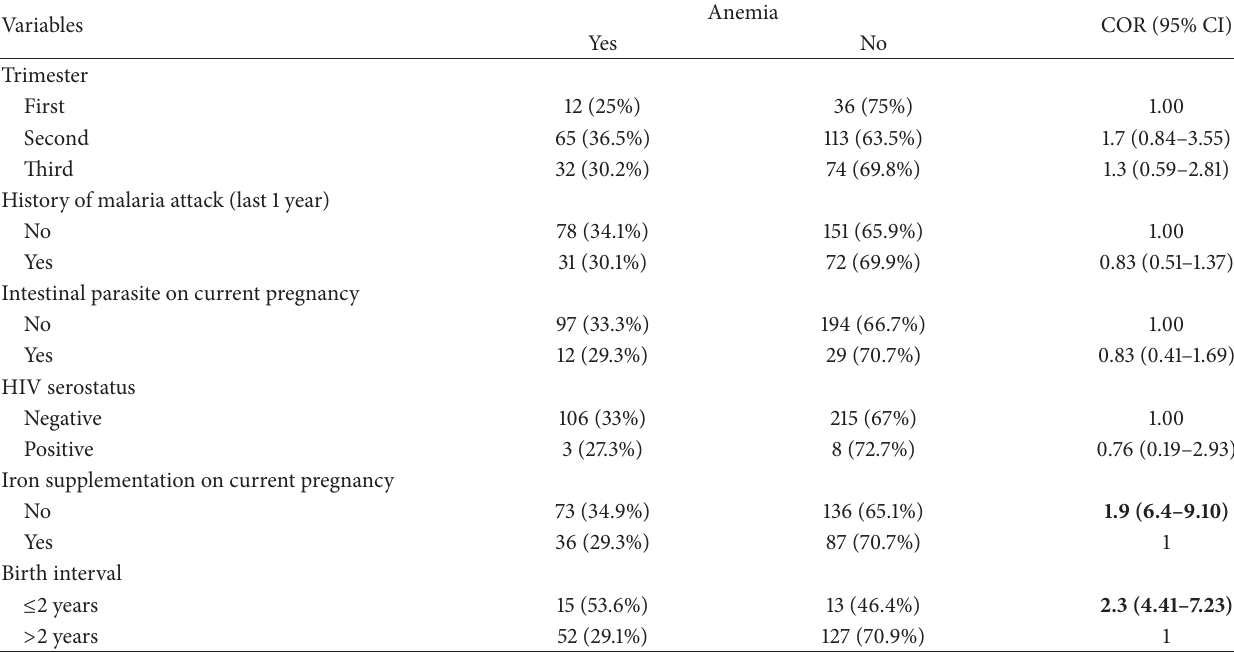
Table 5: Obstetrics factors associated with anemia in pregnancy among ANC attendees in government health institutions of Arba Minch town from February to April 2015 ( 𝑛 = 332 ).